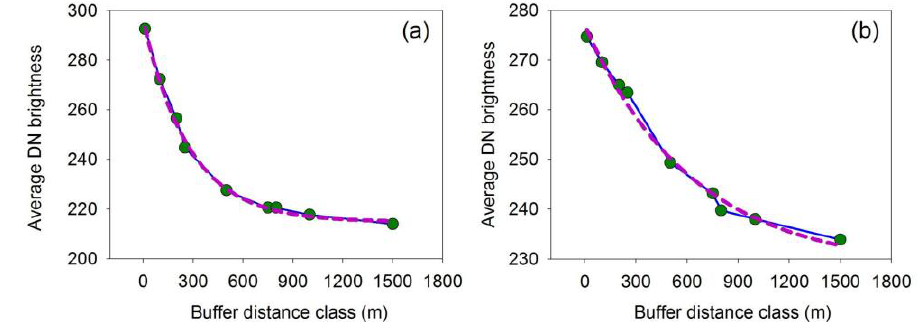
Figure 9. Average luminary brightness within multiple buffers: ( a ) refers to Xinshi road in Wuhan; ( b ) refers to Shengxin road in Ningbo.